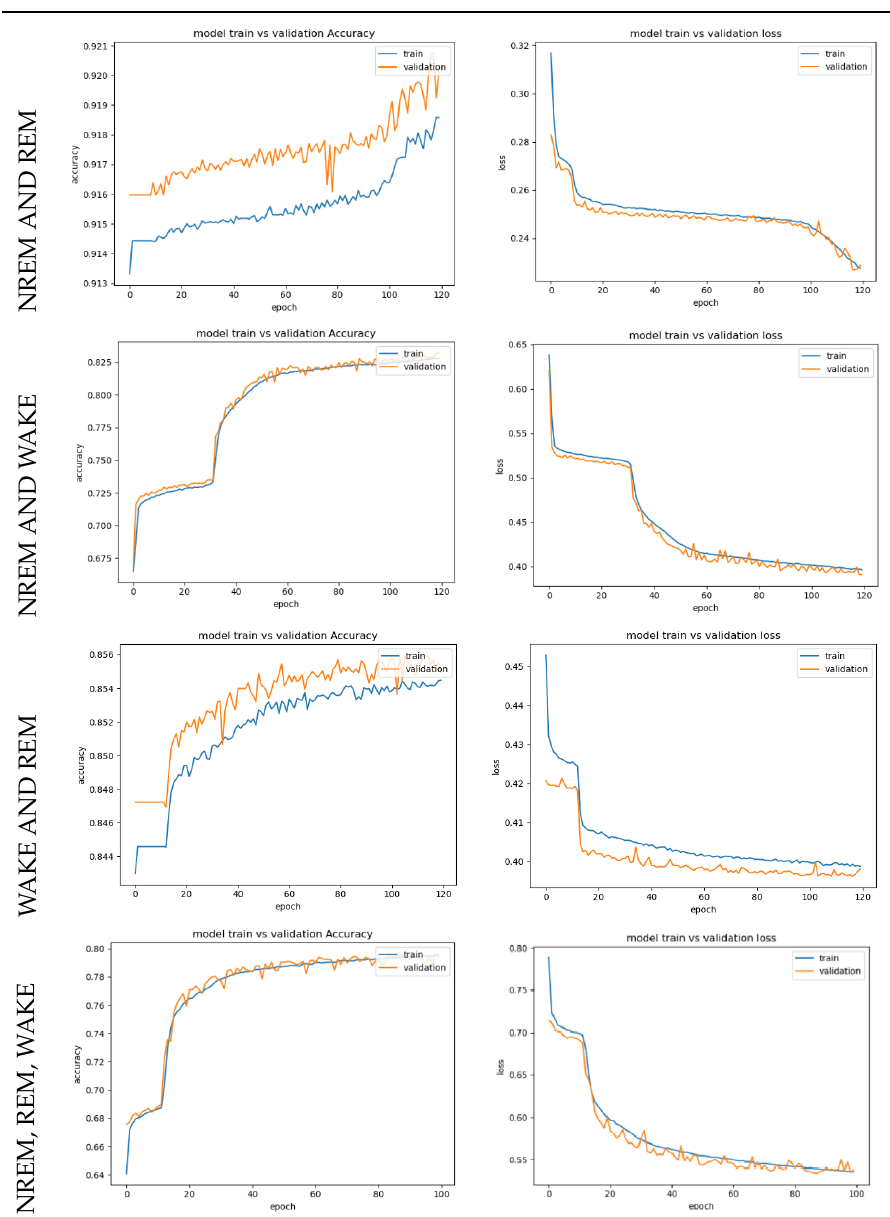
Table 6. Validation loss and accuracy for a single PC